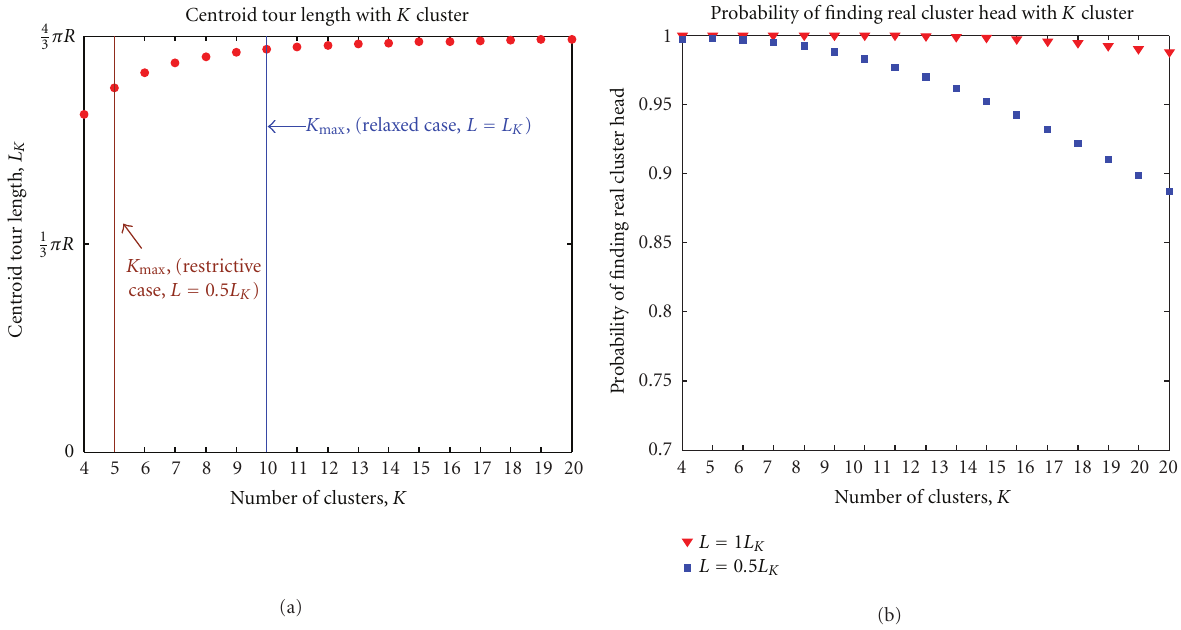
Figure 5: The e ff ect of number of clusters on the BS tour and the probability of finding a real cluster head. (a) The BS tour when r = 1 and R = 5 r . K max is calculated from (5) at relaxed delay requirement. (b) The probability of finding a real cluster head, R = 5 r , from